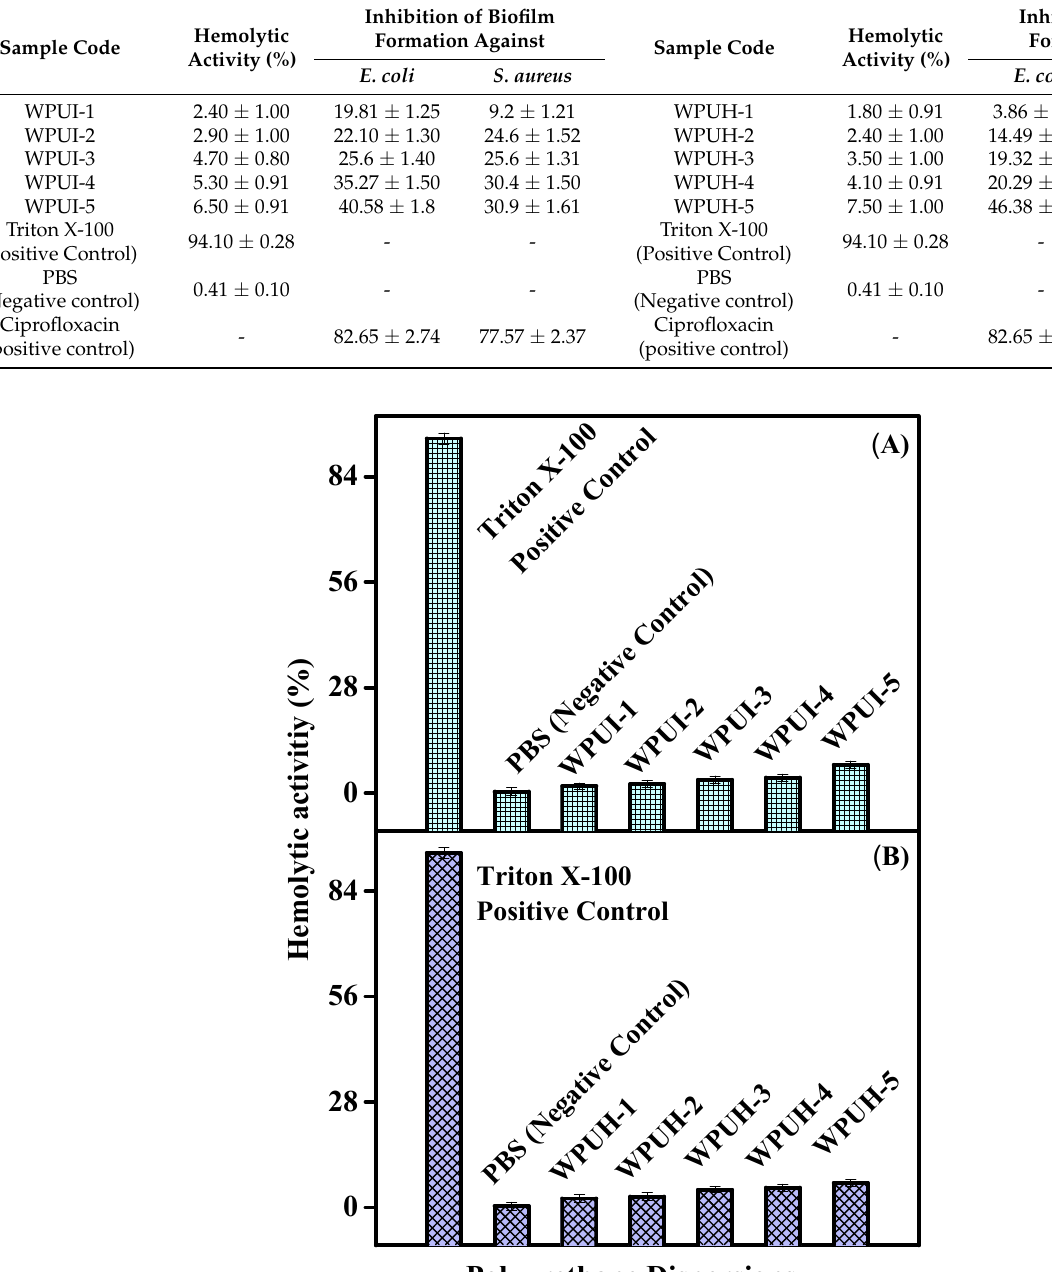
Table 3. Data of bioassays of WPUDs of WPUI and WPUH series.